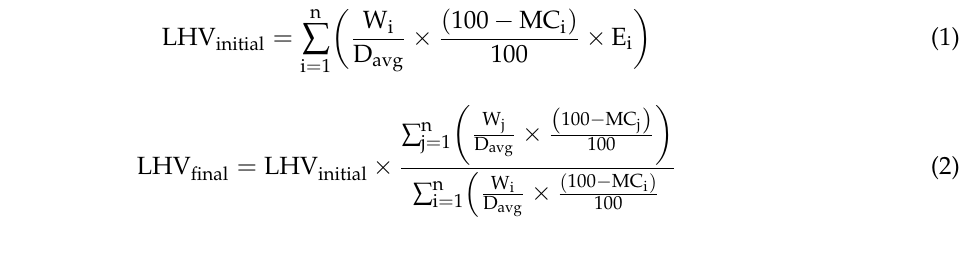
Table 1. The properties of the biodegradable waste samples of Myanmar. Description Quantity Number of samples 12 Total amount of each sample (g) 500 Composition ratio 80:20 (Food wastes: Green leaves/Garden wastes)